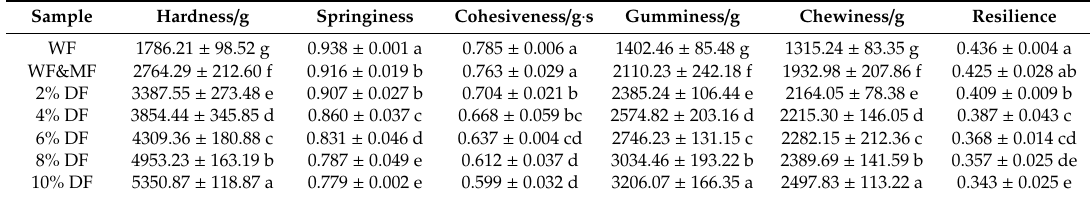
Table 4. Texture parameters of steamed breads with steamed millet flour and